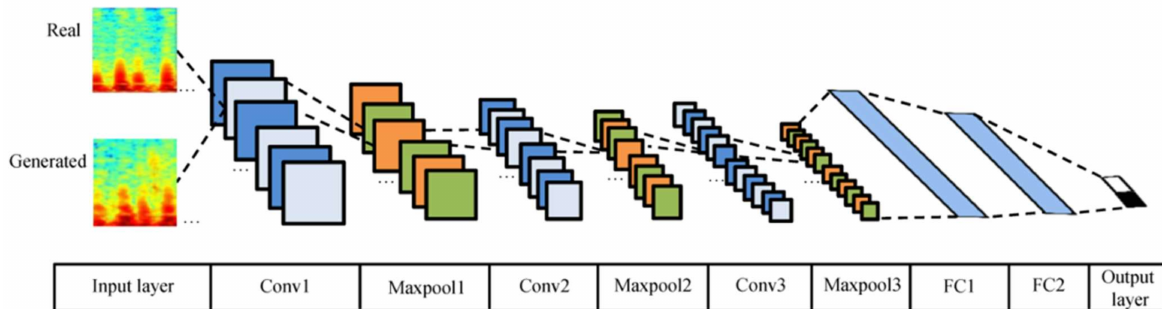
Figure 7. The structure of the CNN